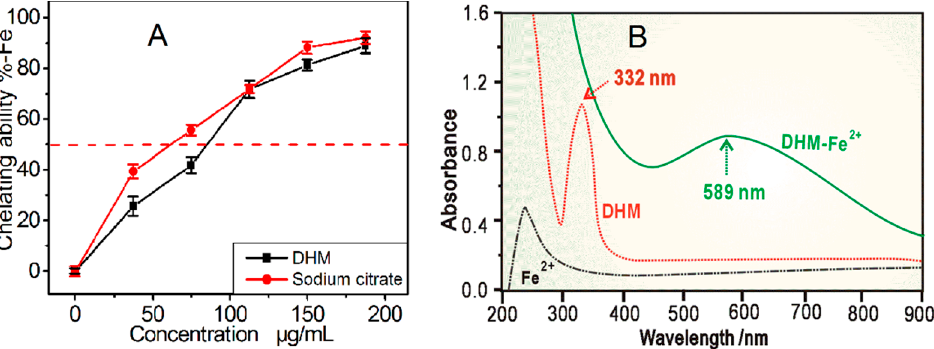
Figure 8. ( A ) The dose response curve of DHM in the Fe 2+ -chelating assay. Sodium citrate is used as the positive control. Each value in ( A ) is expressed as the mean ± SD ( n = 3); ( B ) UV spectra of dihydromyricetin (DHM) and the DHM-Fe 2+ complex.